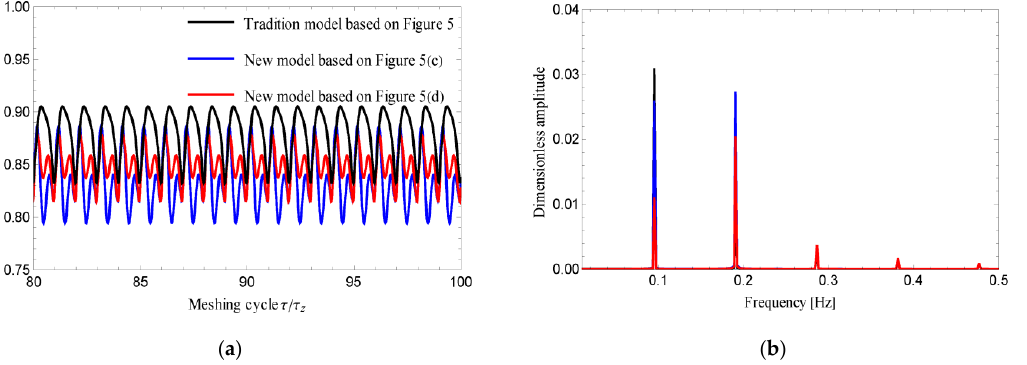
Figure 6. Comparative analysis of dynamics characteristics based on traditional and new model: ( a ) time history diagram; ( b ) FFT spectrogram.